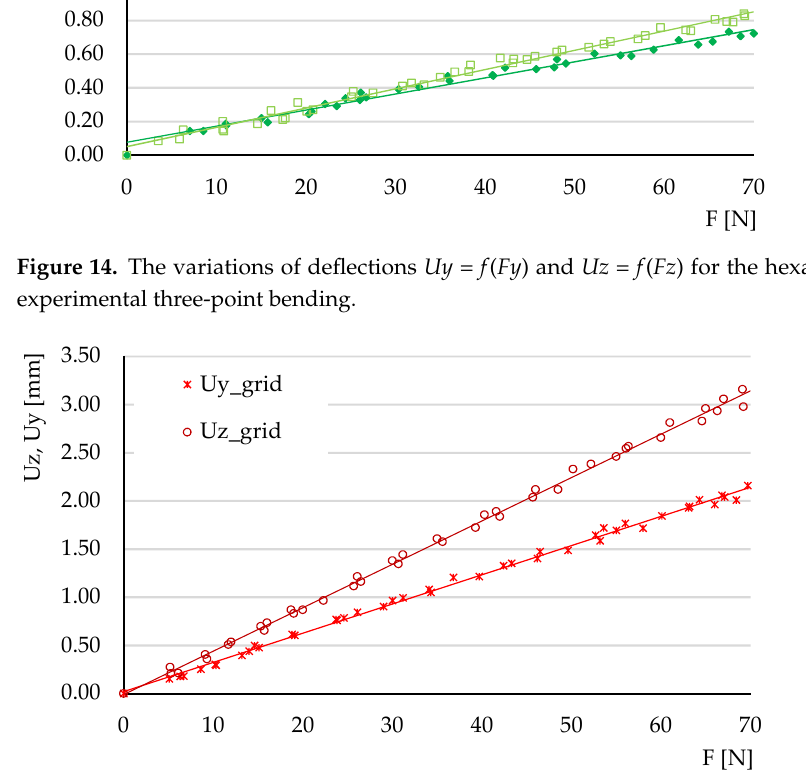
Figure 15. The variations of deflections Uy = f ( Fy ) and Uz = f ( Fz ) for the grid structure, in experimental three-point bending.